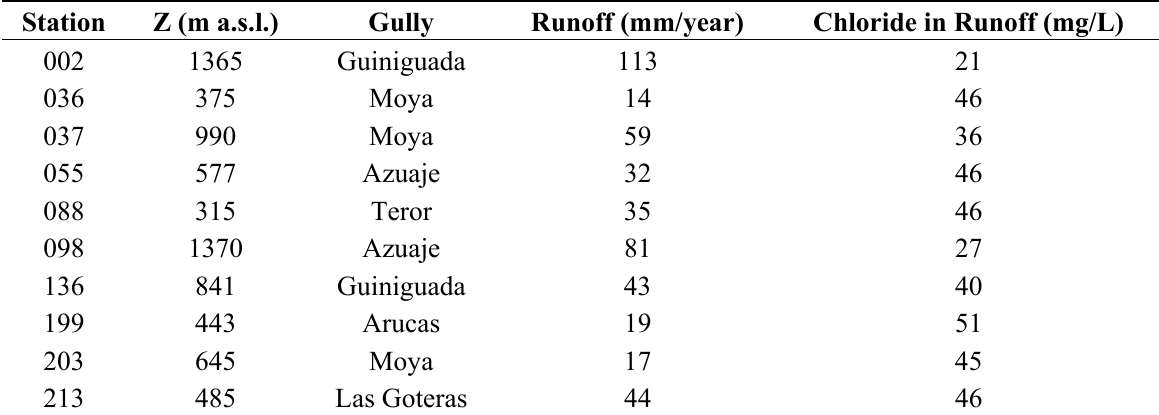
Figure 4. Chloride concentration in runoff samples vs. elevation. Table 3. Average runoff for the 2008–2014 period, estimated by the curve-number method, and the chloride concentration, obtained by estimating the runoff mass flow for the area of influence of each rainwater